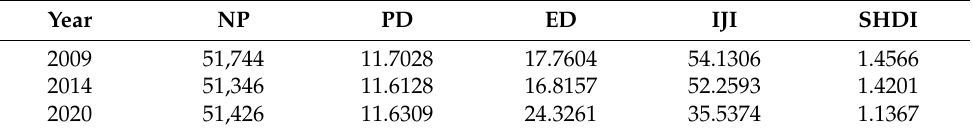
Table 9. The dynamic variation of landscape index in the study area in 2009–2020. Year NP PD ED